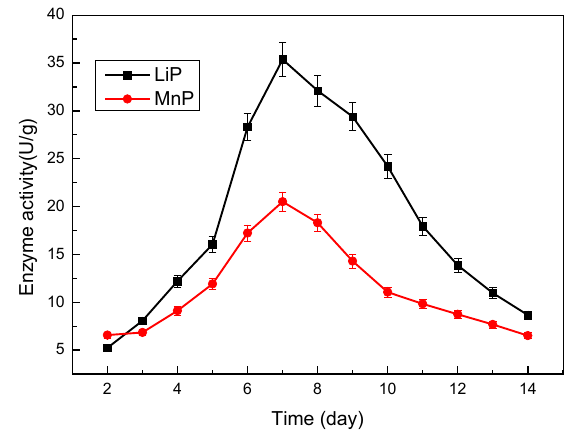
Figure 4: Activities of LiP and MnP during the solid-state